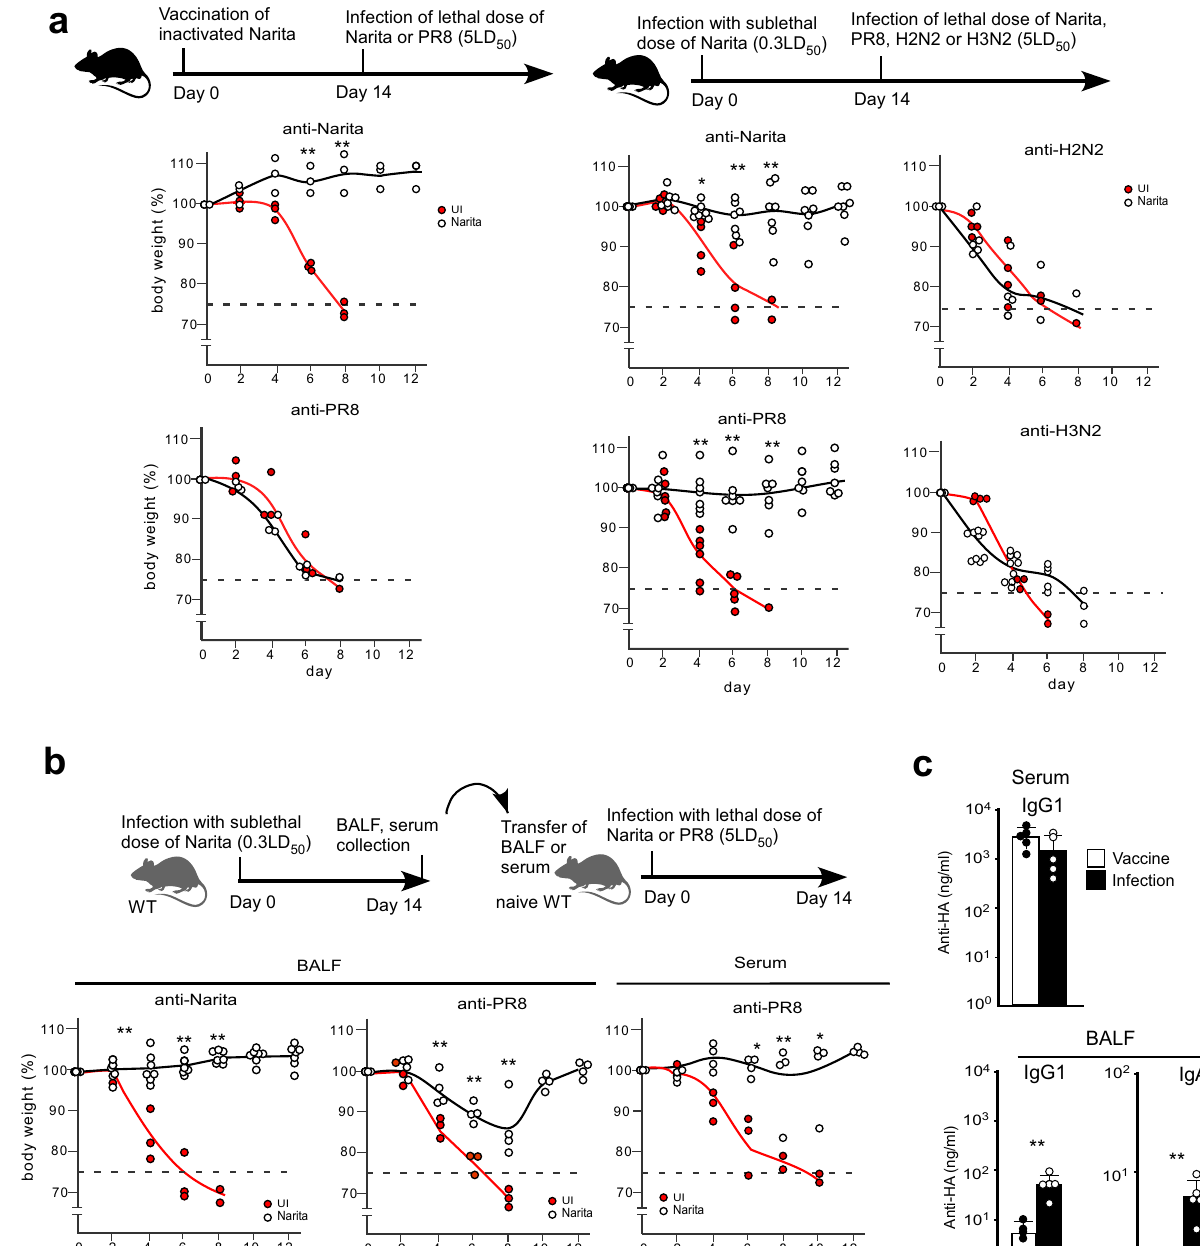
Fig. 1 Live virus infection confers broadly protective humoral responses. a Top panel indicates the design of the experiments for protection against heterotypic virus infection. Mice immunized by intraperitoneal vaccination with an inactivated whole virus (left n = 3) or by intranasal infection (right) of A/Narita/1/2009 were intranasally challenged with a lethal dose of A/Narita/1/2009 ( n = 5), A/PR/8/1934 ( n = 7), A/Okuda/1957 (H2N2 n = 5), or X31 (H3N2 n = 9) at 14 days post-immunization. The body weight changes were analyzed in the mice with or without (UI marked with red dots; n = 3 – 6) immunization. b Top panel indicates the design of the passive transfer experiment. Mice were intranasally administered BALF or serum (60 µ g/ml anti- Narita IgG) from mice infected with A/Narita/1/2009 followed by intranasal challenge with a lethal dose of A/Narita/1/2009 (left n = 6) or A/PR/8/ 1934 (middle and right n = 4 for each). The body weight changes were analyzed in the mice administered BALFs from uninfected (UI marked with red dots; n = 3 – 4) or infected mice. The mice whose body weight fell below 75% of the starting weight were euthanized. c A/H1N1pdm09 HA-speci fi c serum IgG1 (top) and BALF IgG1 and IgA titers were measured in mice intranasally immunized by vaccination using inactivated whole A/Narita/1/2009 (white bars; n = 5) or by sublethal infection with A/Narita/1/2009 (black bars; n = 5). UI represents unimmunized. Bars represent mean; * p < 0.05, ** p < 0.01 by un p aired, two-tailed t -test (UI group with t he other group in a and b , Vaccine group with Infection group in c ). All error bars represent